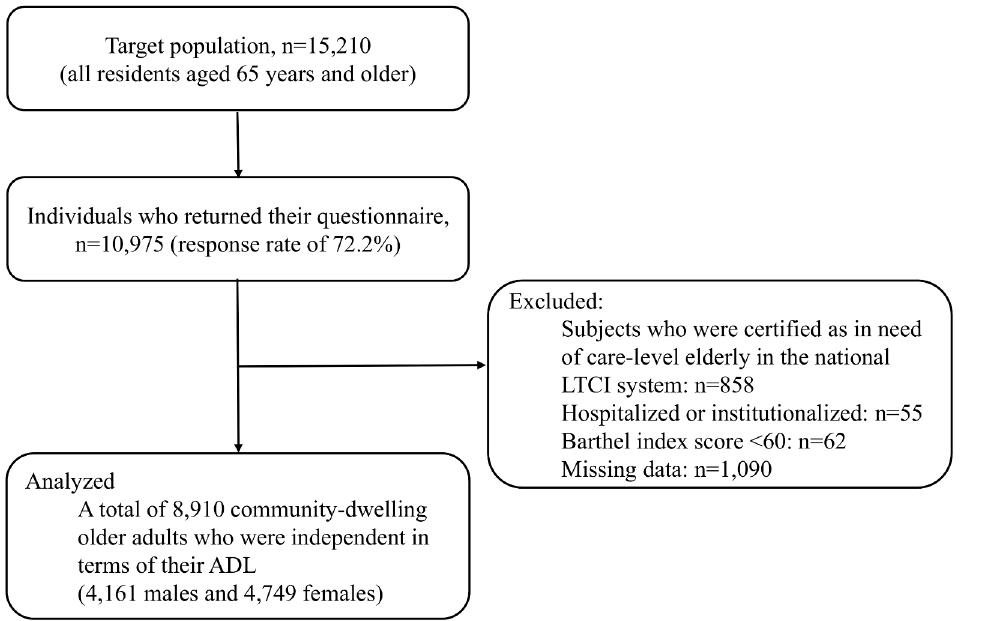
Fig 1. Selection of subjects. ADL, activities of daily living; LTCI, long-term care insurance.